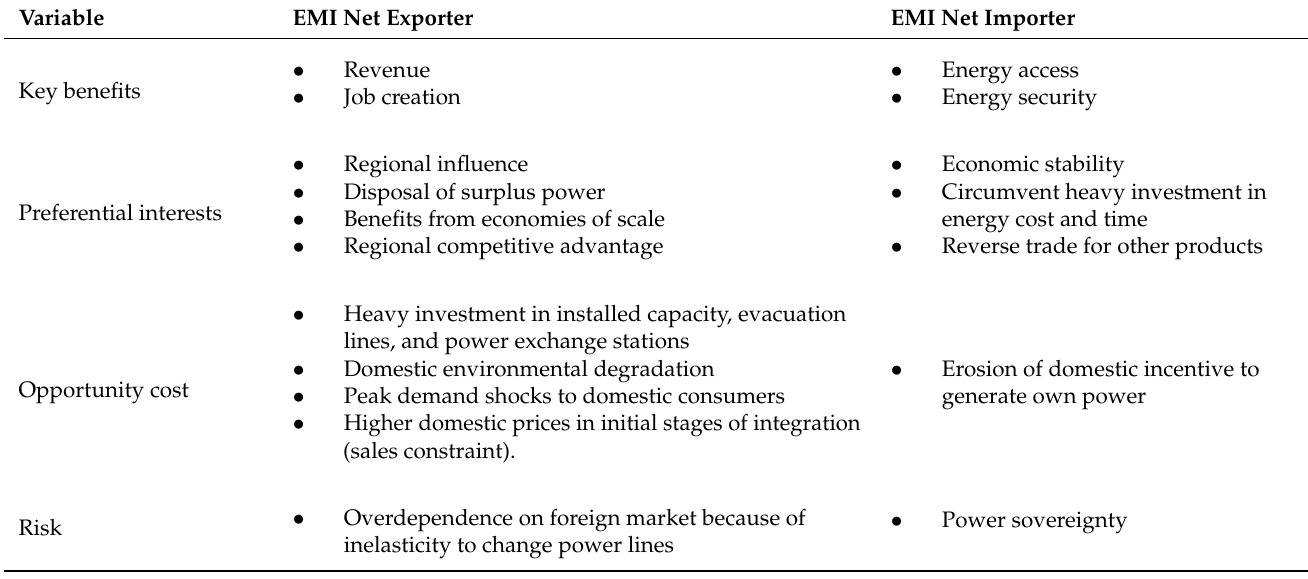
Table 4. Stylized trade-off of exporters and importers in EMI.